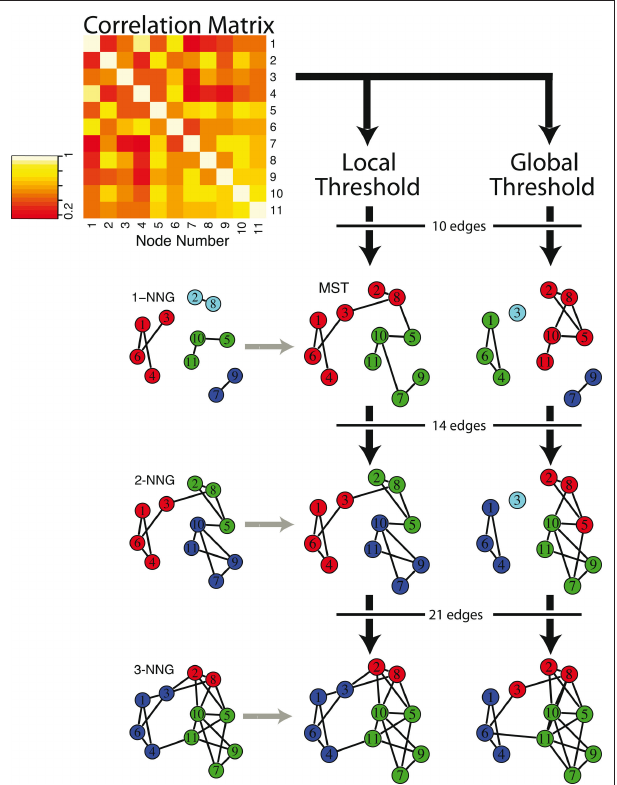
Figure 1 | Schematic illustrating local and global thresholding methods, and how these methods impact on the modular structure of graphs constructed from a correlation matrix. Starting with a model correlation matrix, which shows the functional connectivity between a subset of 11 brain regions for one subject, the two different thresholding methods are used to construct graphs with increasing numbers of edges. On the left, applying a local threshold produces connected supersets of the k nearest neighbor graph ( k -NGG), which includes edges for each node’s k highest functional connections, shown here for k = 1, 2, 3. The minimum spanning tree (MST) is a connected superset of the 1-NNG, and connects all 11 nodes with the lowest possible number of edges and the highest possible functional connectivity. On the right, applying a global threshold simply includes edges between the pairs of nodes with the highest functional connectivity in order. Nodes of the same color are in the same module, as determined by the fast greedy algorithm, showing the influence of graph construction and edge density on the modular